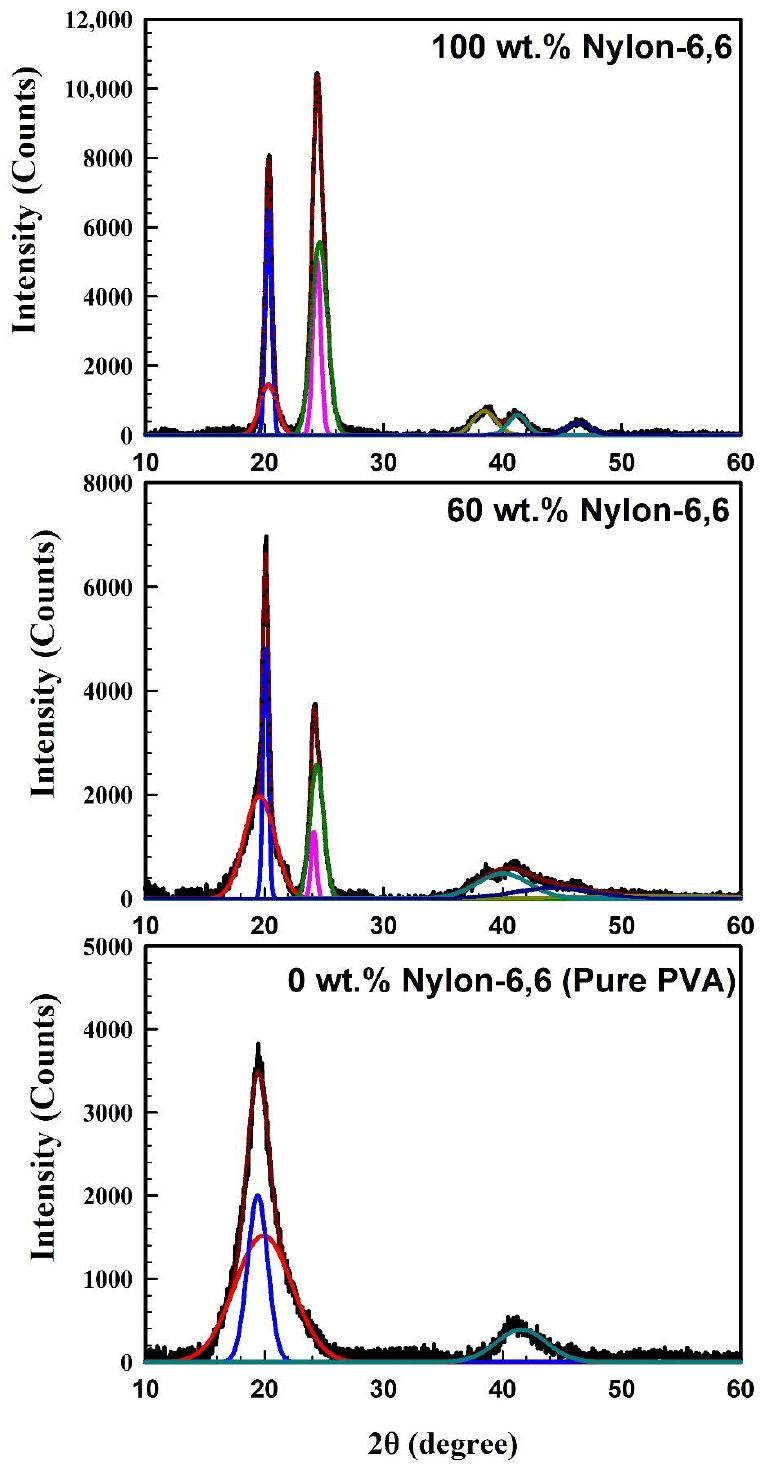
Figure 3. WAXD spectra for pure Nylon-6,6, polymer blend (60 wt.% Nylon-6,6), and pure PVA. The blue and pink peaks represent the crystalline peaks while the red and green peaks represent the amorphous peaks for the samples.